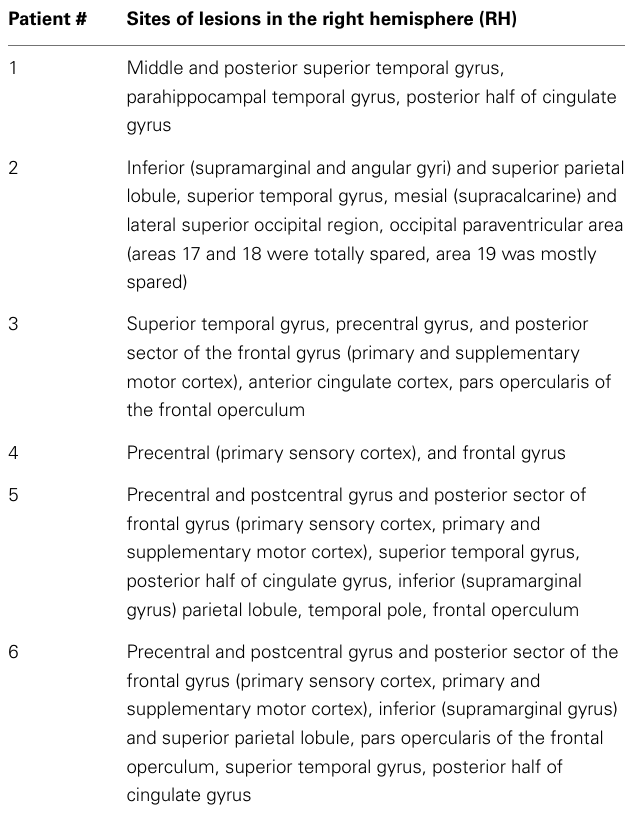
and Methods for further